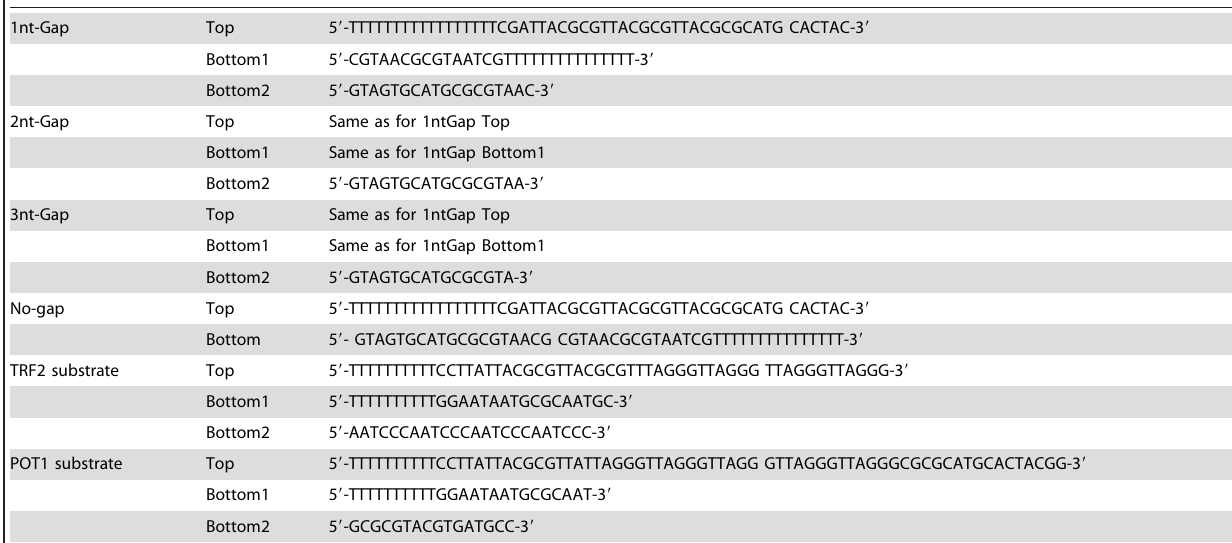
Table 1. Sequences of oligomers used for the making of DNA substrates.